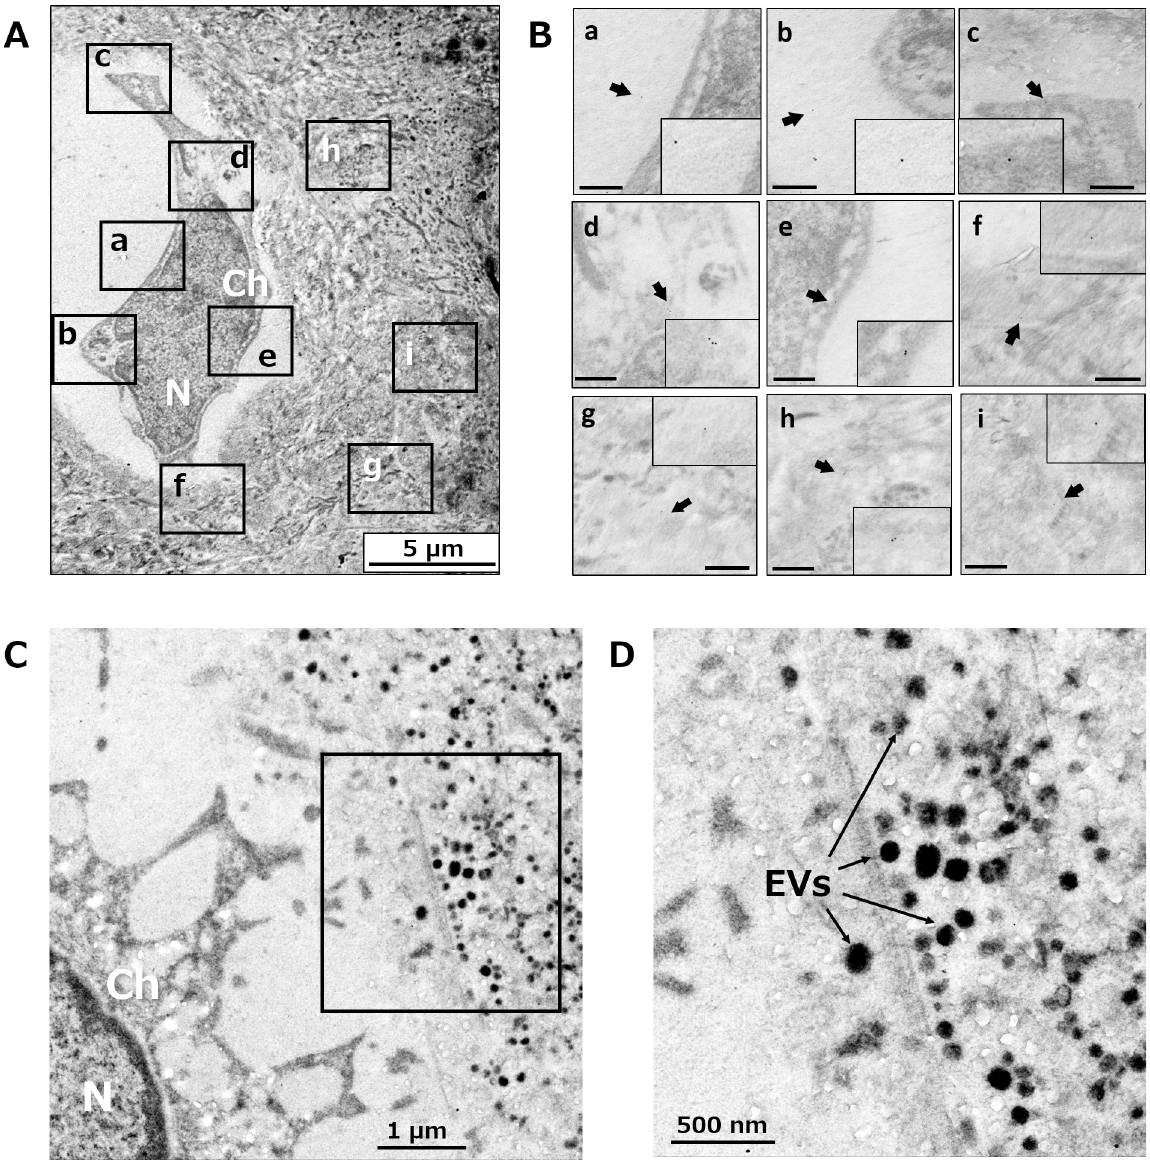
Fig 3. Evaluation of RANKL expression in articular cartilage by immunoelectron microscopy. The localization of 10 nm colloidal gold particles labeled RANKL antibody are observed as electron–dense punctate. (A and C) Lower magnification micrograph of deep layer chondrocyte and surrounding matrix. (B) Insets of A showing localization of immunogold at pericellular matrix (a, b), cytoplasm and cell membrane (c, d, e), and territorial matrix surrounding chondron (f, g, h, i). Scale bars = 500 nm. (D) Inset of C showing extracellular vesicles scattered randomly with the territorial matrix without labeling by colloidal gold, indicating these vesicles do not contain RANKL. Ch, chondrocyte; N, nucleus; EVs, extracellular vesicles.